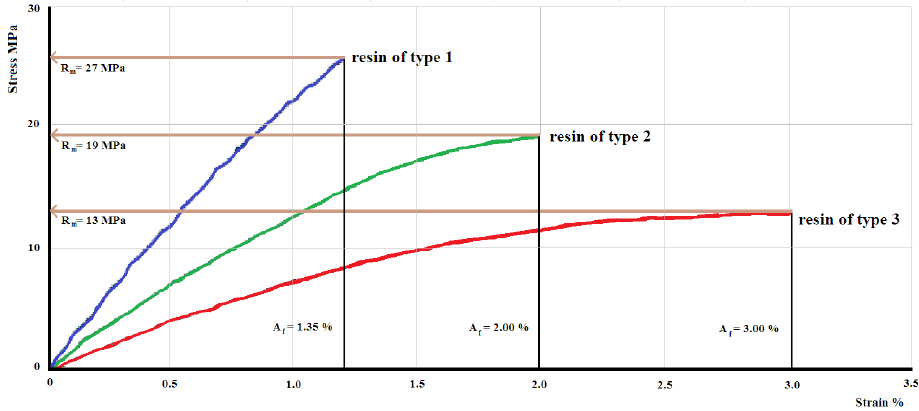
Figure 4. Characteristic curves for a representative sample of each set of samples from the obtained hybrid